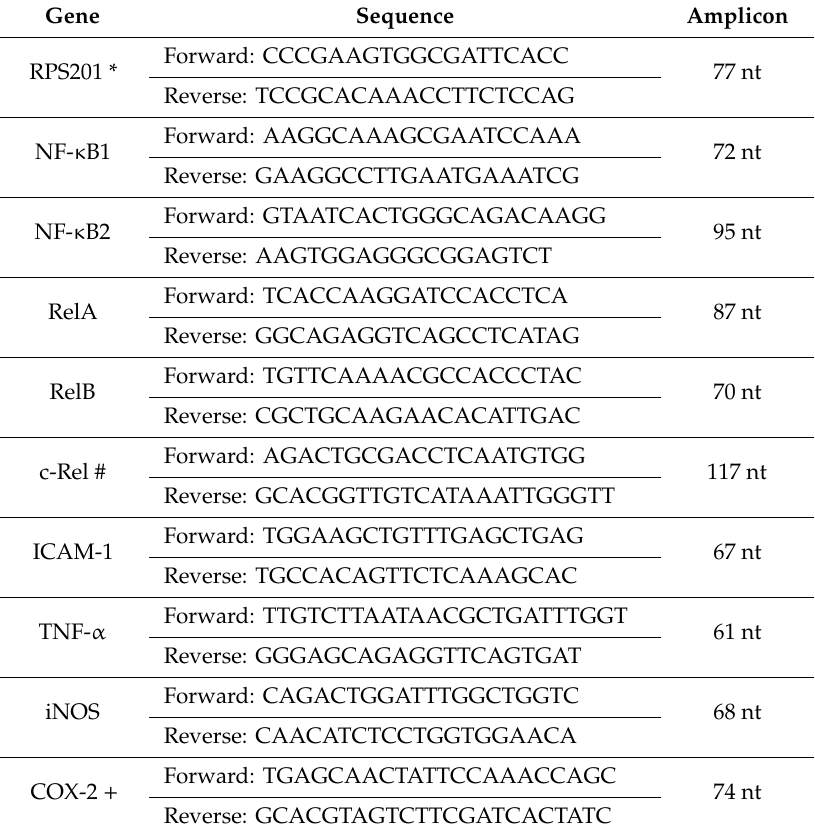
Table 1. qPCR primers for NF- κ B-related